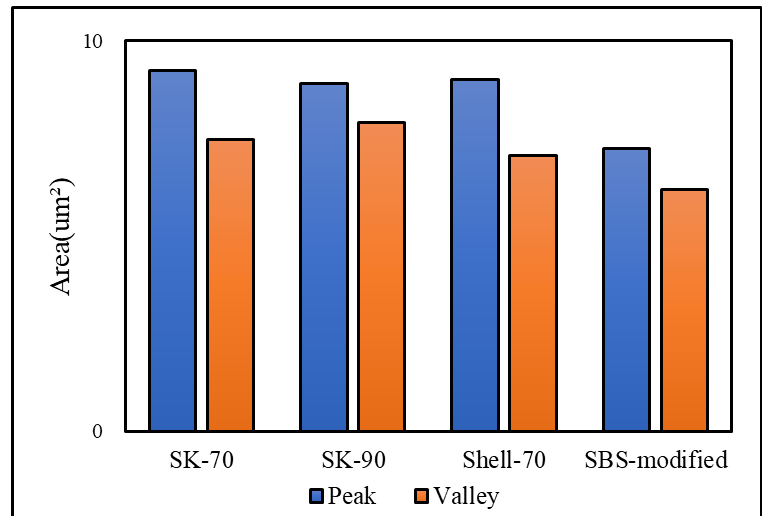
Figure 18. The area of bee-like structure in asphalt doped with RAA.